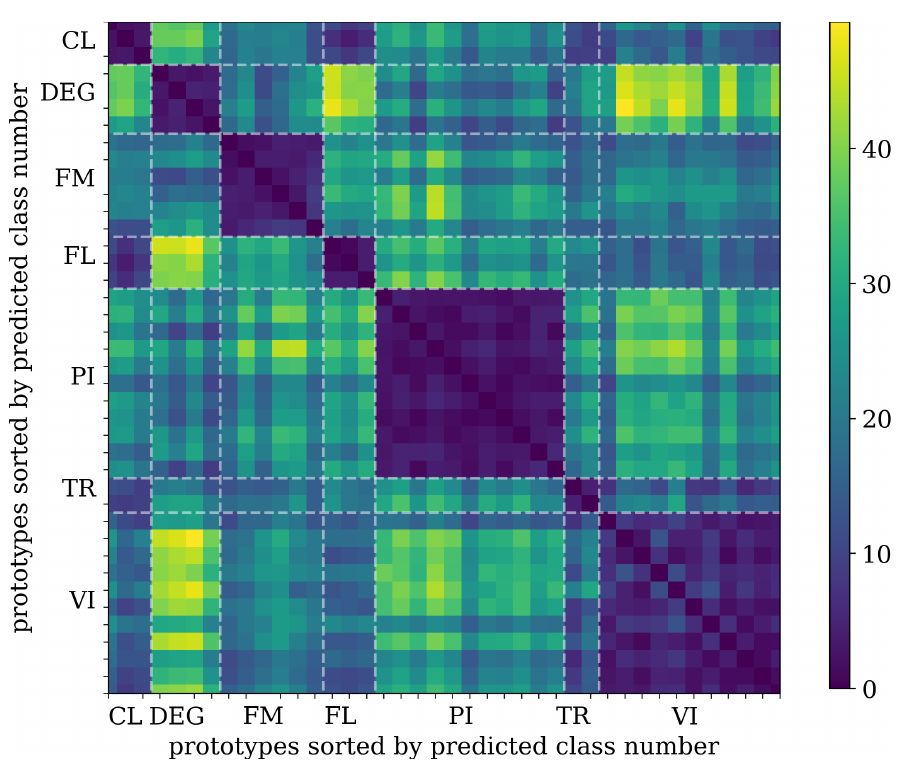
Figure 9. Distance matrix of prototypes of the Medley-solos-DB dataset sorted by predicted classes. The labels are clarinet (CL), distorted electric guitar (DEG), female singer (FM), flute (FL), piano (PI), trumpet (TR), and violin